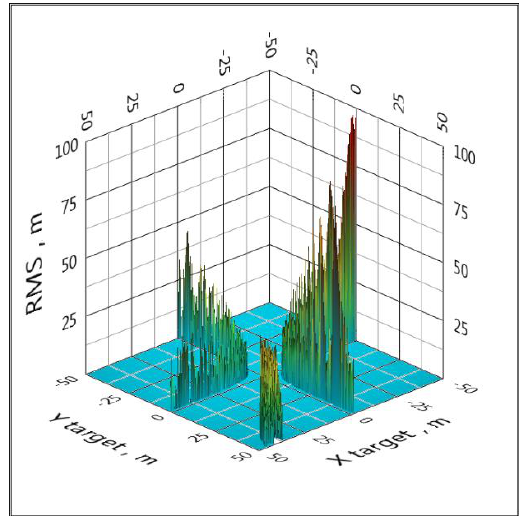
Figure 5. An example of gross errors at the points at which the determinant of the system of equations vanishes (LPS).